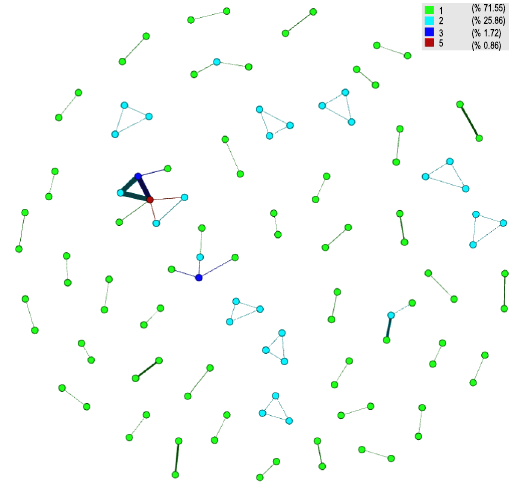
Fig. 2. Small scale project